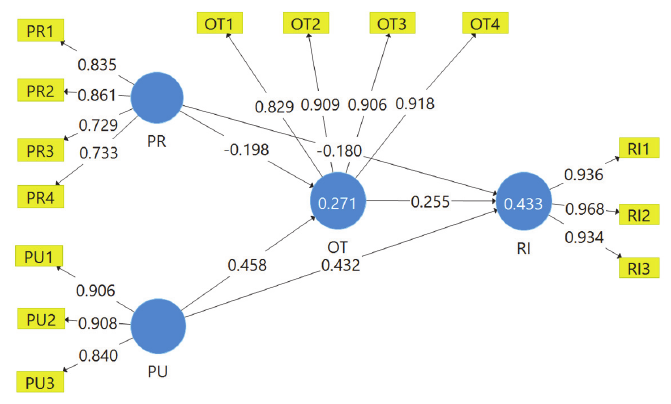
Fig. 2. Loading Factor